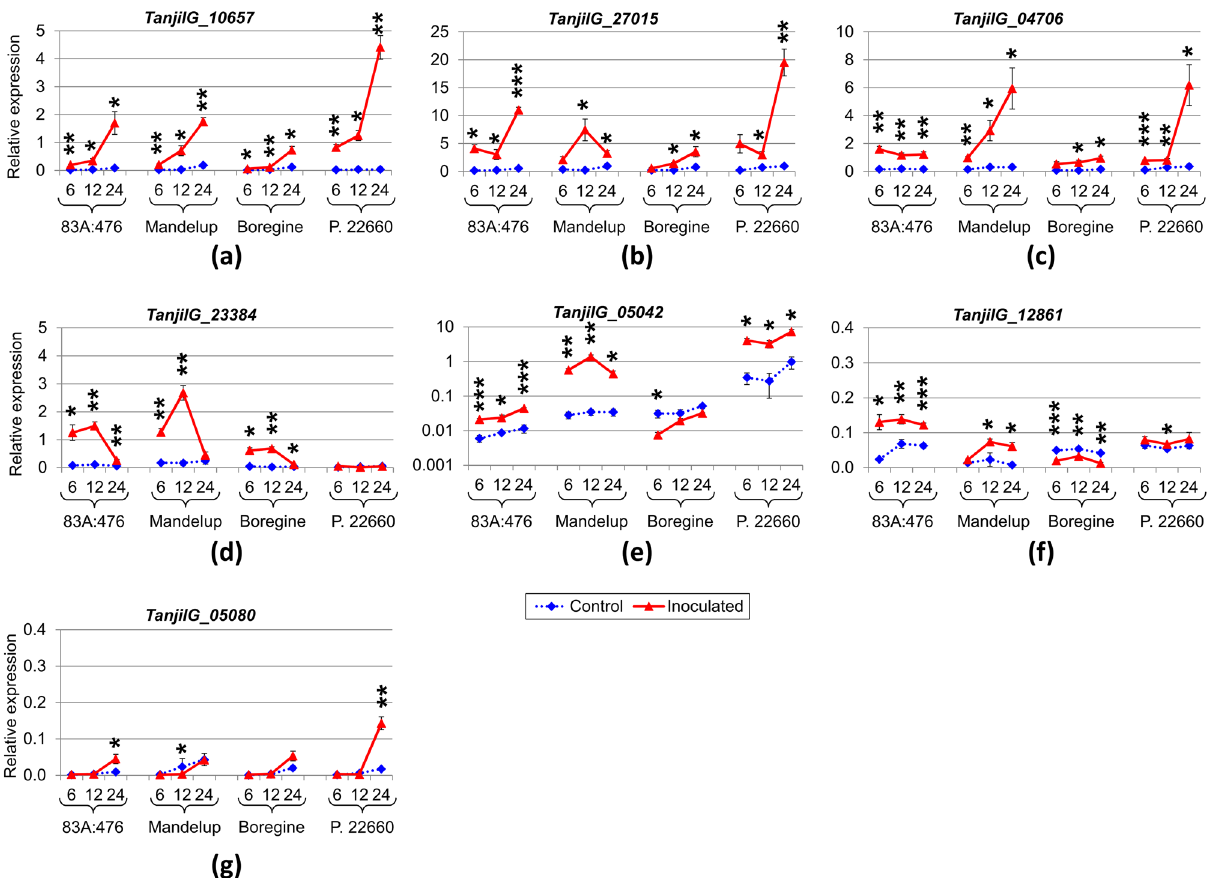
Figure 6. Expression profiles of selected genes ( a – g ) revealed by quantitative PCR. The numbers 6, 12, and 24 stand for hours post inoculation. LanDExH7 and LanTUB6 genes were used for the normalization, and LanTUB6 for the inter-run calibration. The error bars indicate the standard deviation based on three biological replicates, each representing a mean of three technical replicates. The statistical significance of differences in the expression levels between the inoculated ( Colletotrichum lupini , strain Col-08, obtained in 1999 from the lupin field in Wierzenica, Poland) and control (mock-inoculated) plants are marked above data points (*P value < 0.05, **P value ≤ 0.01, ***P value ≤ 0.001). Analyzed NLL lines were as follows: 83A:476 (resistant, carrying homozygous Lanr1 allele), Mandelup (moderately resistant, carrying homozygous AnMan allele), Boregine (resistant, unknown genetic background), and Population 22660